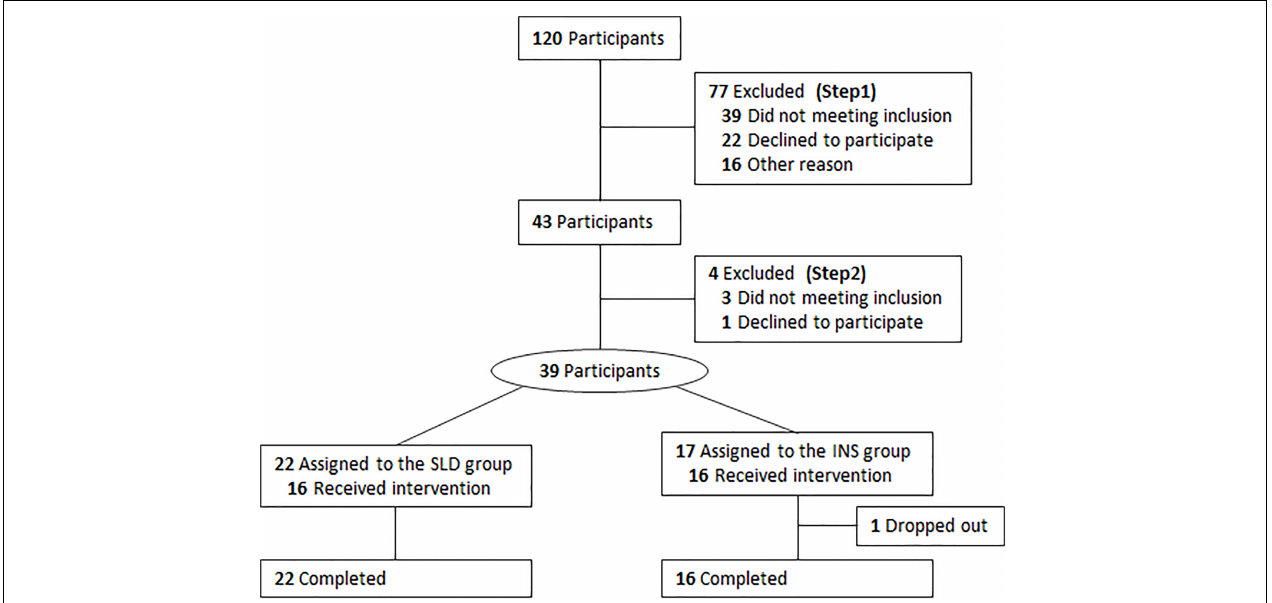
FIGURE 1 | Flowchart diagram of the study protocol from entry to completion. SLD, sleep difficulty; INS, insomnia